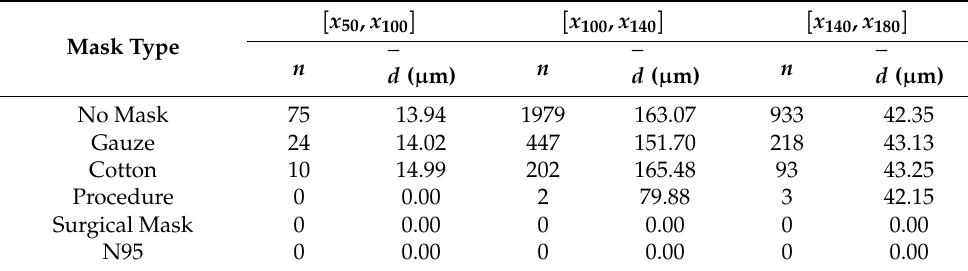
Table 5. The predicted droplet number at various horizontal distance